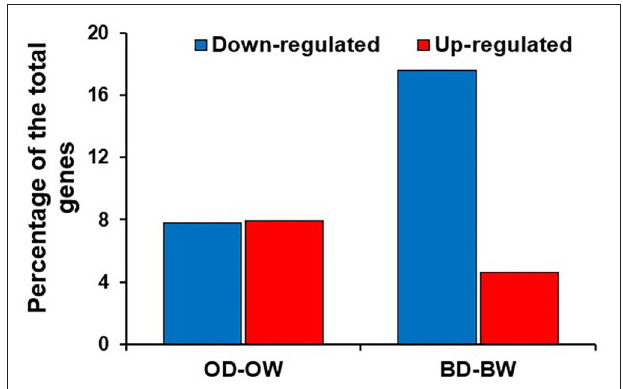
FIGURE 6 | Percentage of DEGs encoding kinases in Otis and Baronesse under